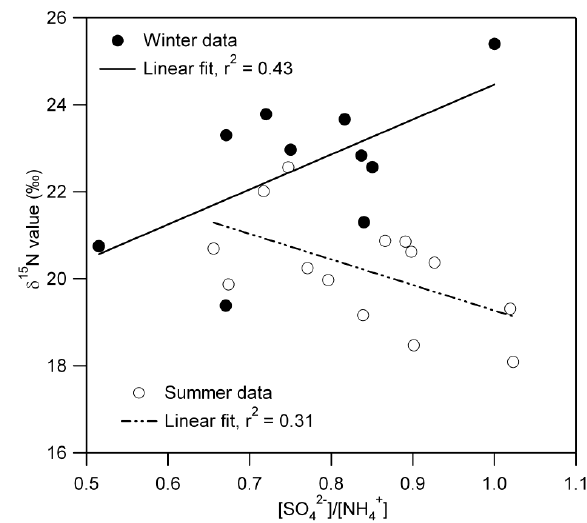
Fig. 8. Relation between δ 15 N values of TN and molar ratios of SO 2 − to NH + in summer and winter aerosols ( r 2 is based on the 4 4 complete data for respective